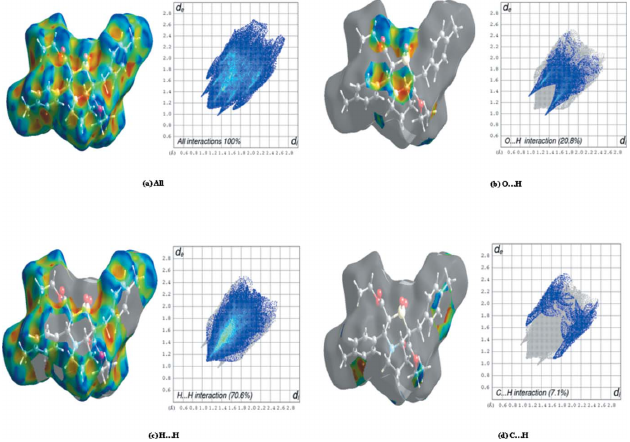
Figure 6 Hirshfeld surface of compound (II) mapped over shape-index and decomposed finger print plots of dominant interactions showing ( a ) all, ( b ) O (cid:2)(cid:2)(cid:2) H, ( c ) H (cid:2)(cid:2)(cid:2) H and ( d ) C (cid:2)(cid:2)(cid:2) H